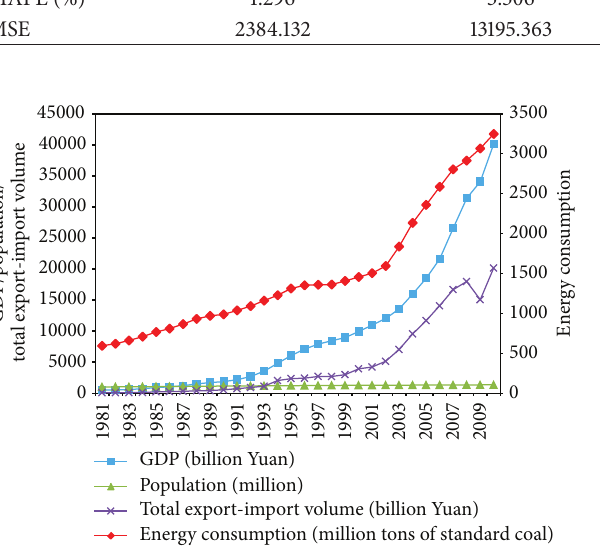
Figure 5: Annual energy consumption, GDP, population, and total export-import volume of China between 1981 and 2010.